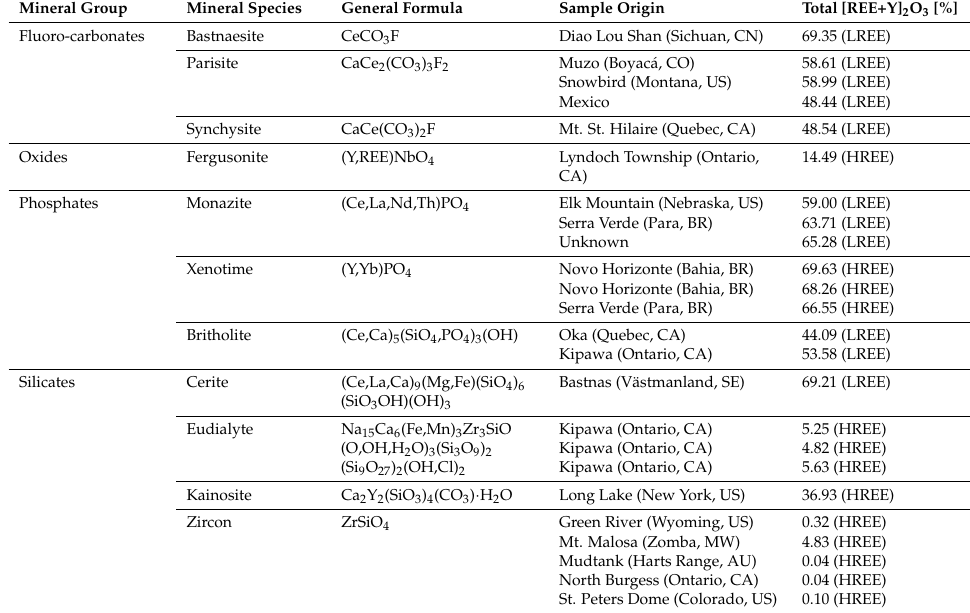
Table 1. Overview of the investigated mineral samples with formulae, origin and electron micro probe analysis (EMPA) average total rare earth element (REE) content [19]. Dominance of LREE (La to Gd) versus HREE (Tb to Lu+Y) is